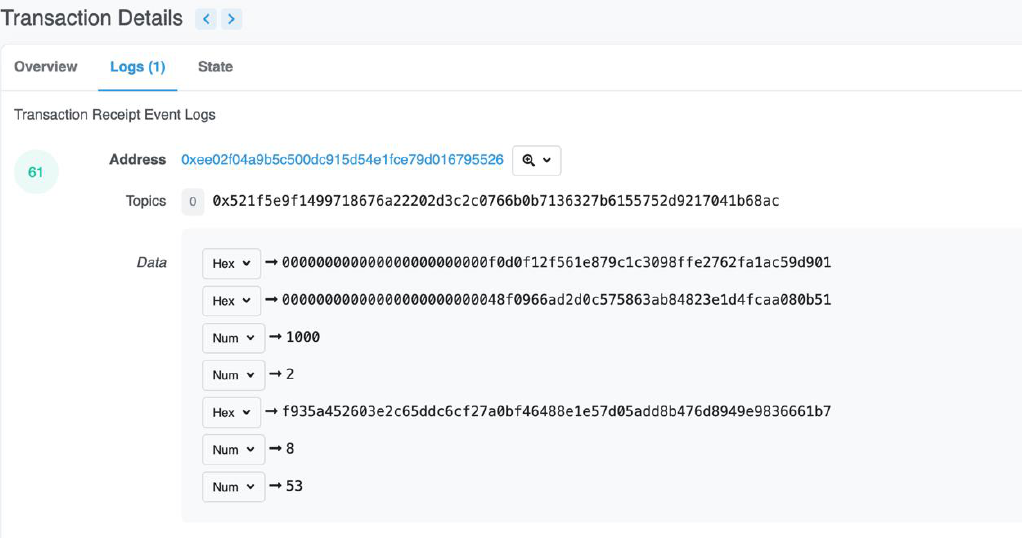
Figure A9. Logs of minting conditional tokens transaction on Etherscan.